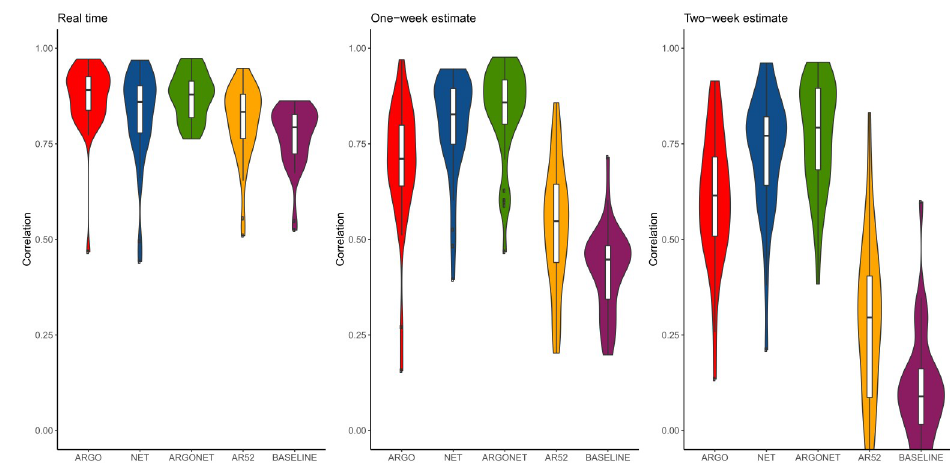
Fig 15. Coefficients Nouvelle-Aquitaine two-week ahead